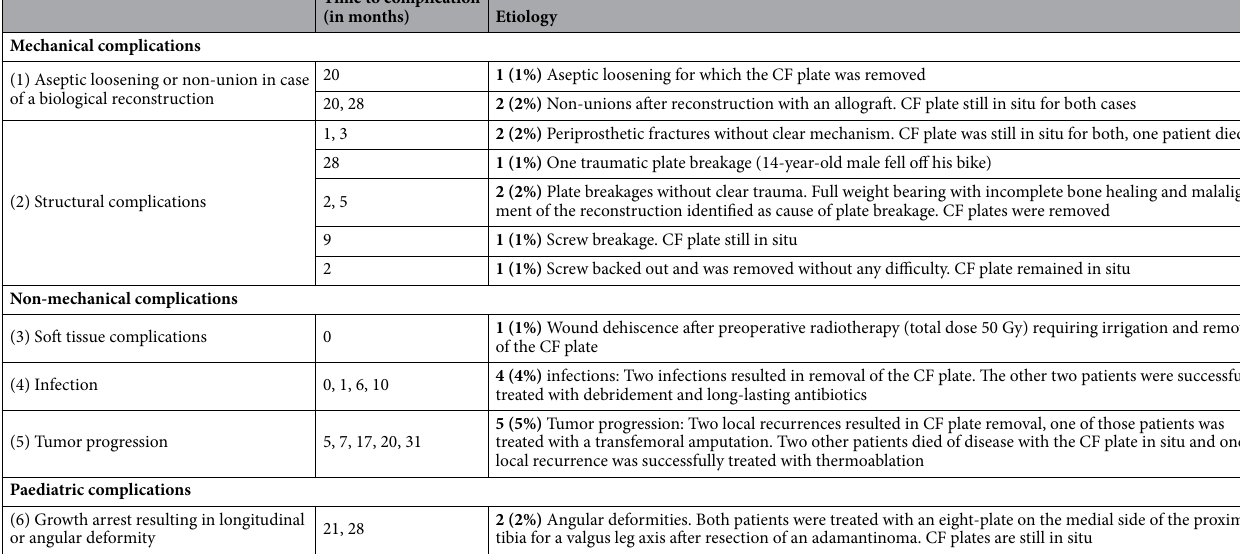
Table 2. Complications of patients with bone tumors treated with carbon-fiber plates. CF = carbon-fiber.